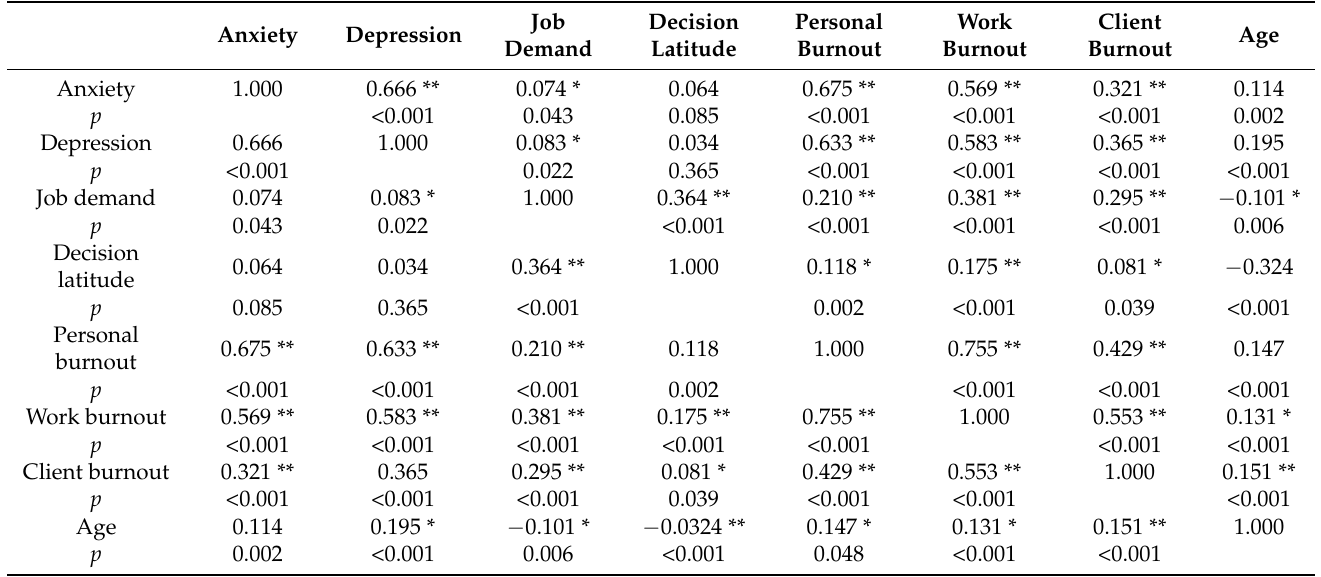
Table 3. Bivariate